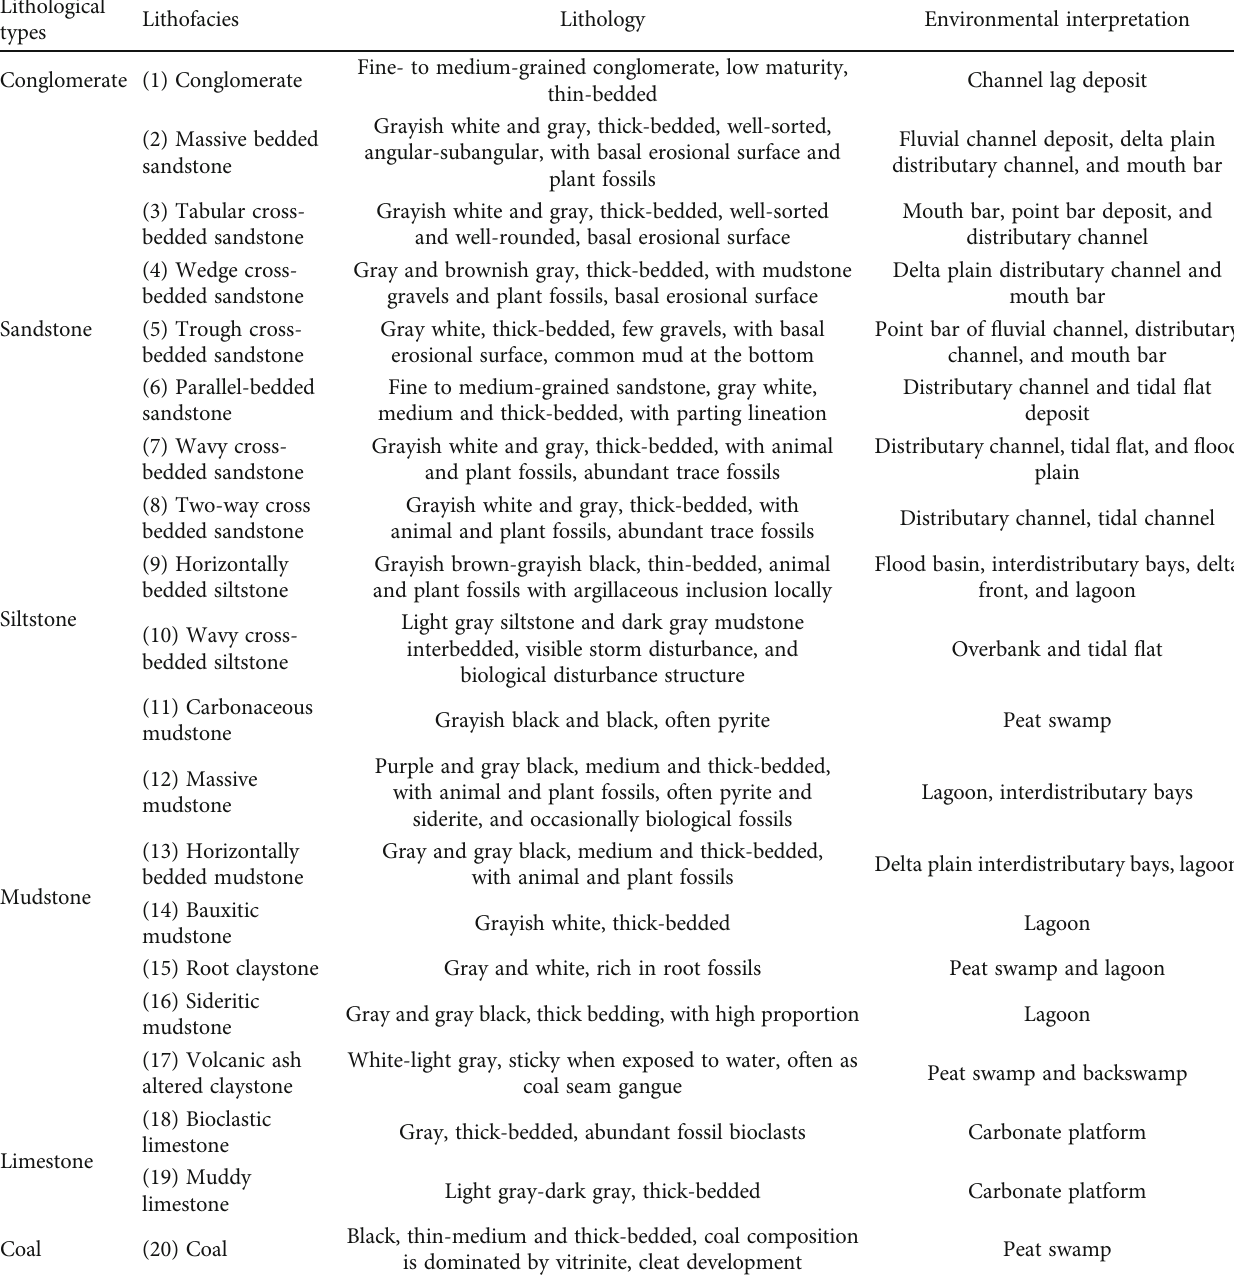
Table 1: Dominant lithofacies of the Lopingian coal-bearing strata in southern